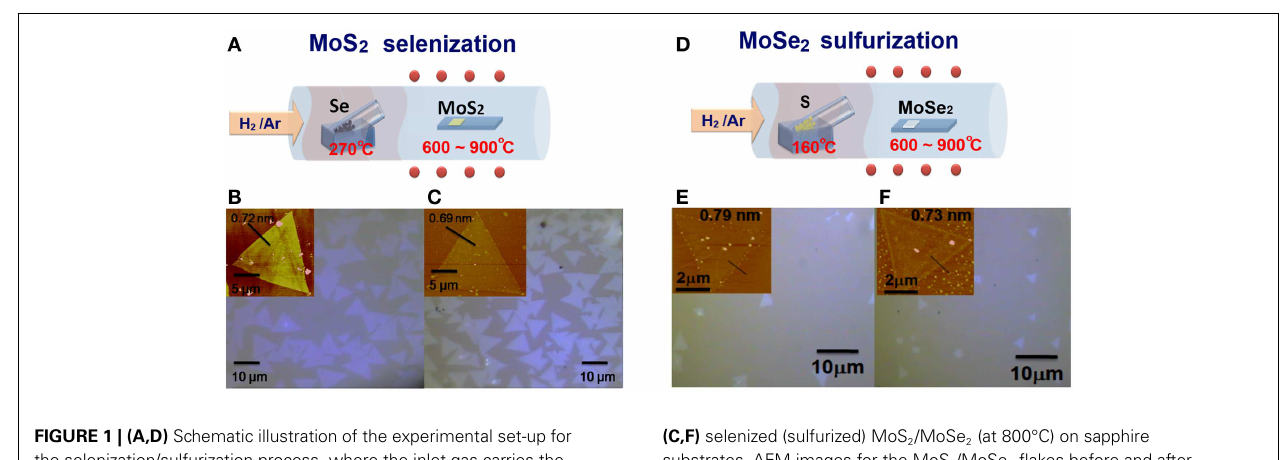
(C,F) selenized (sulfurized) MoS 2 /MoSe 2 (at 800°C) on sapphire substrates. AFM images for the MoS 2 /MoSe 2 flakes before and after selenization (sulfurization) (at 800°C) are shown as insets in OM